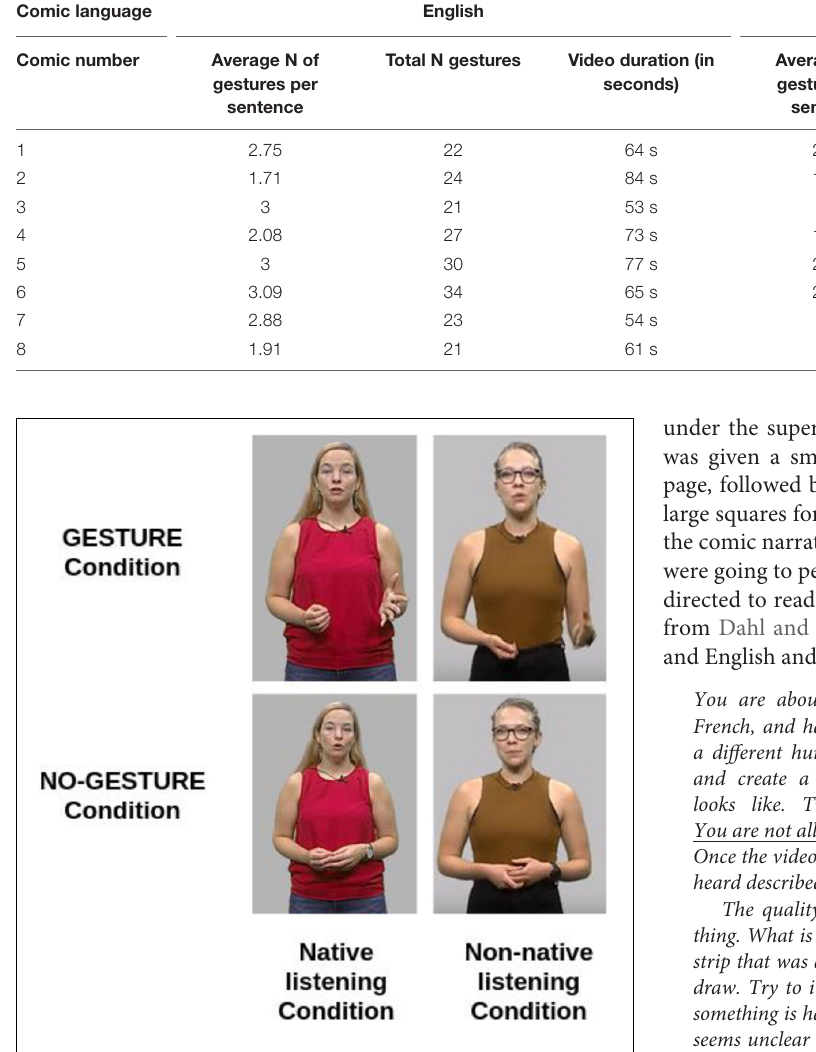
FIGURE 2 | Still-frames taken from the stimuli videos of one narration in each